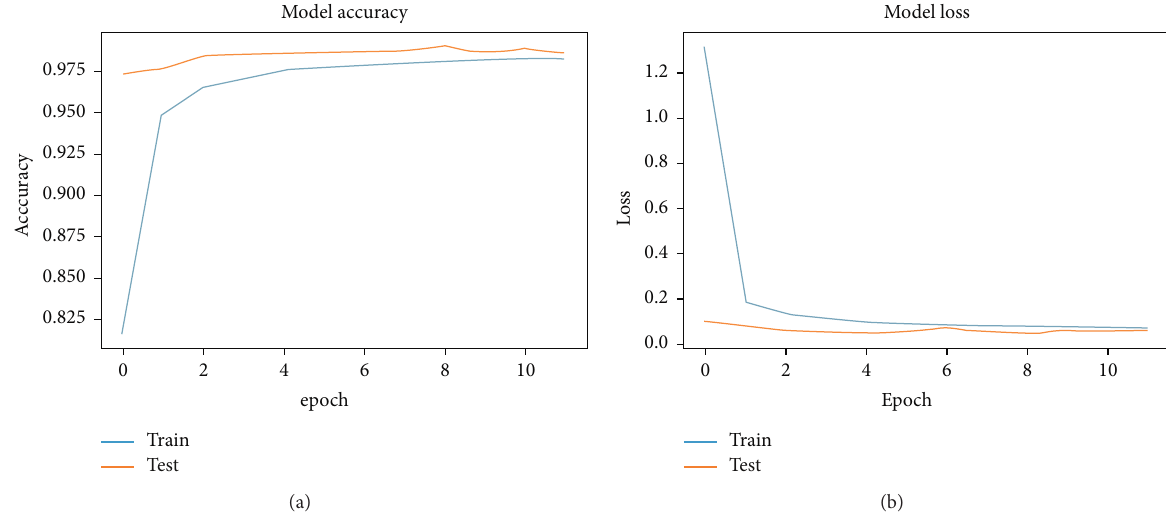
Figure 12: Accuracy and loss curves. (a) Accuracy vs. epoch. (b) Loss vs.